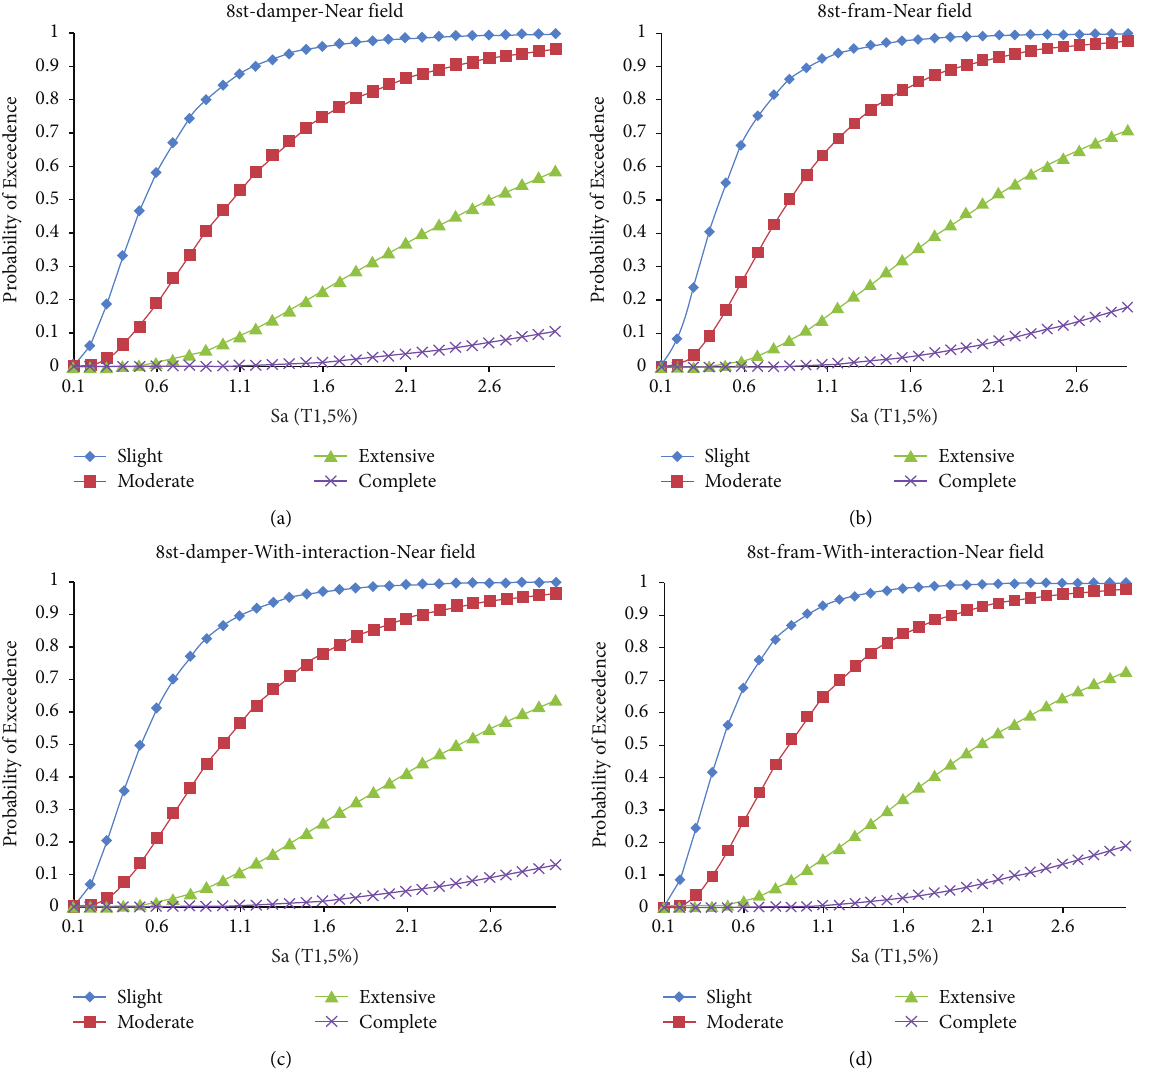
Figure 10: Fragility curves in 8-story ordinary moment resisting frame affected by near-field earthquakes. Examined cases: (a) with damper without considering SSI; (b) without damper and SSI effect; (c) with damper and considering SSI; (d) without damper but considering SSI